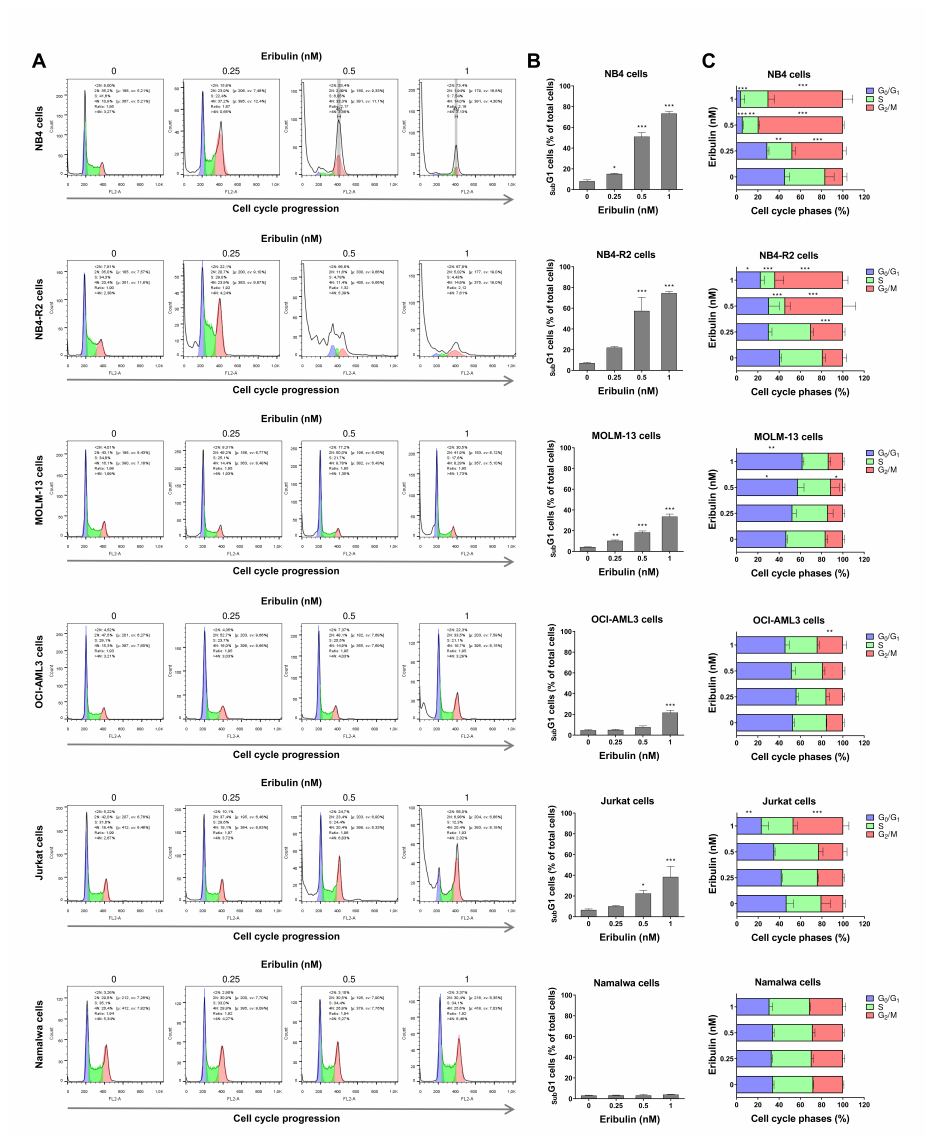
Figure 3. Eribulin arrests the cell cycle at G 2 /M in leukemia cells. Cell cycle phases were determined by DNA content analysis by propidium iodide staining and flow cytometry in NB4, NB4-R2, MOLM- 13, OCI-AML3, Jurkat, and Namalwa cells treated with eribulin (0.25, 0.5, and 1 nM) or vehicle for 72 h. ( A ) A representative histogram for each condition is presented. ( B ) The vertical bar graph represents the mean ± SD of the cell percentages in subG 1 from at least three independent experiments. ( C ) The horizontal bar graph represents the mean ± SD of cell distributions in the G 0 /G 1 , S, and G 2 /M phases of the cell cycle (excluding subG 1 ) from at least three independent experiments. The p values and cell lines are indicated in the graphs; * p < 0.05, ** p < 0.01, *** p < 0.001; ANOVA and Bonferroni